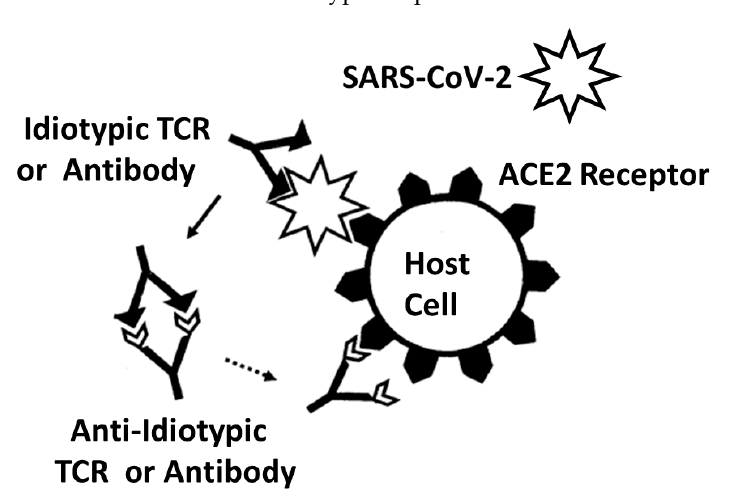
Figure 11. Schematic diagram summarizing the anti-idiotype theory of autoimmune disease induction [113–115]. In essence, a virus such as SARS-CoV-2 will induce a TCR and/or antibody idiotypic immune response (antibodies are illustrated for simplicity). If the idiotypic immune response is sufficiently robust, it may induce an anti-idiotypic response (solid arrow). The resulting TCRs or antibodies will then mimic the inducing antigen, in this case SARS-CoV-2, and target the same host cell receptors as does the virus (dotted arrow), in this case, the angiotensin-converting enzyme type 2 (ACE-2) receptor. This theory could explain how expanded TCR sequences mimic SARS-CoV-2 antigens but does not explain how these TCR sequences also mimic host autoantigens or their specific mimicry of bacteria known to co-infect COVID-19 patients.